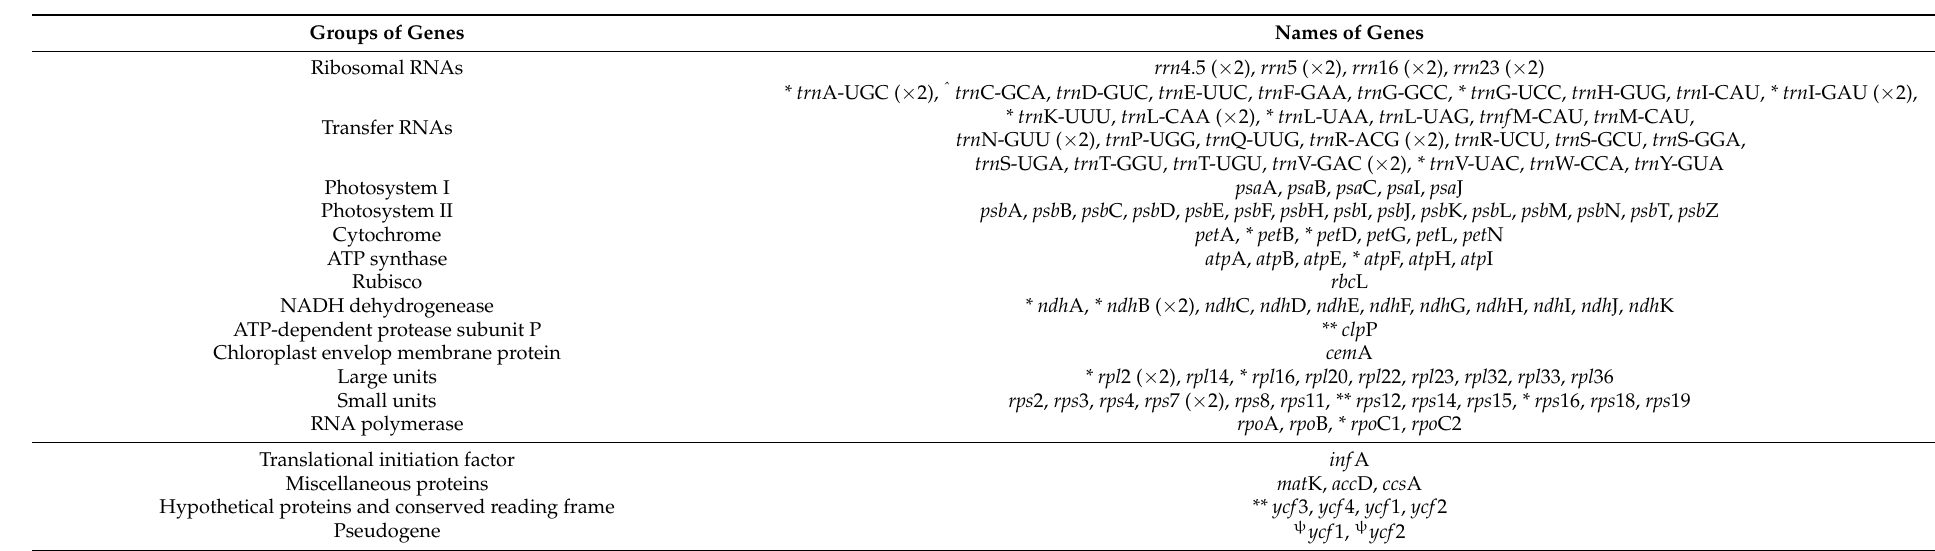
Table 2. List of genes in the chloroplast genomes of Litsea